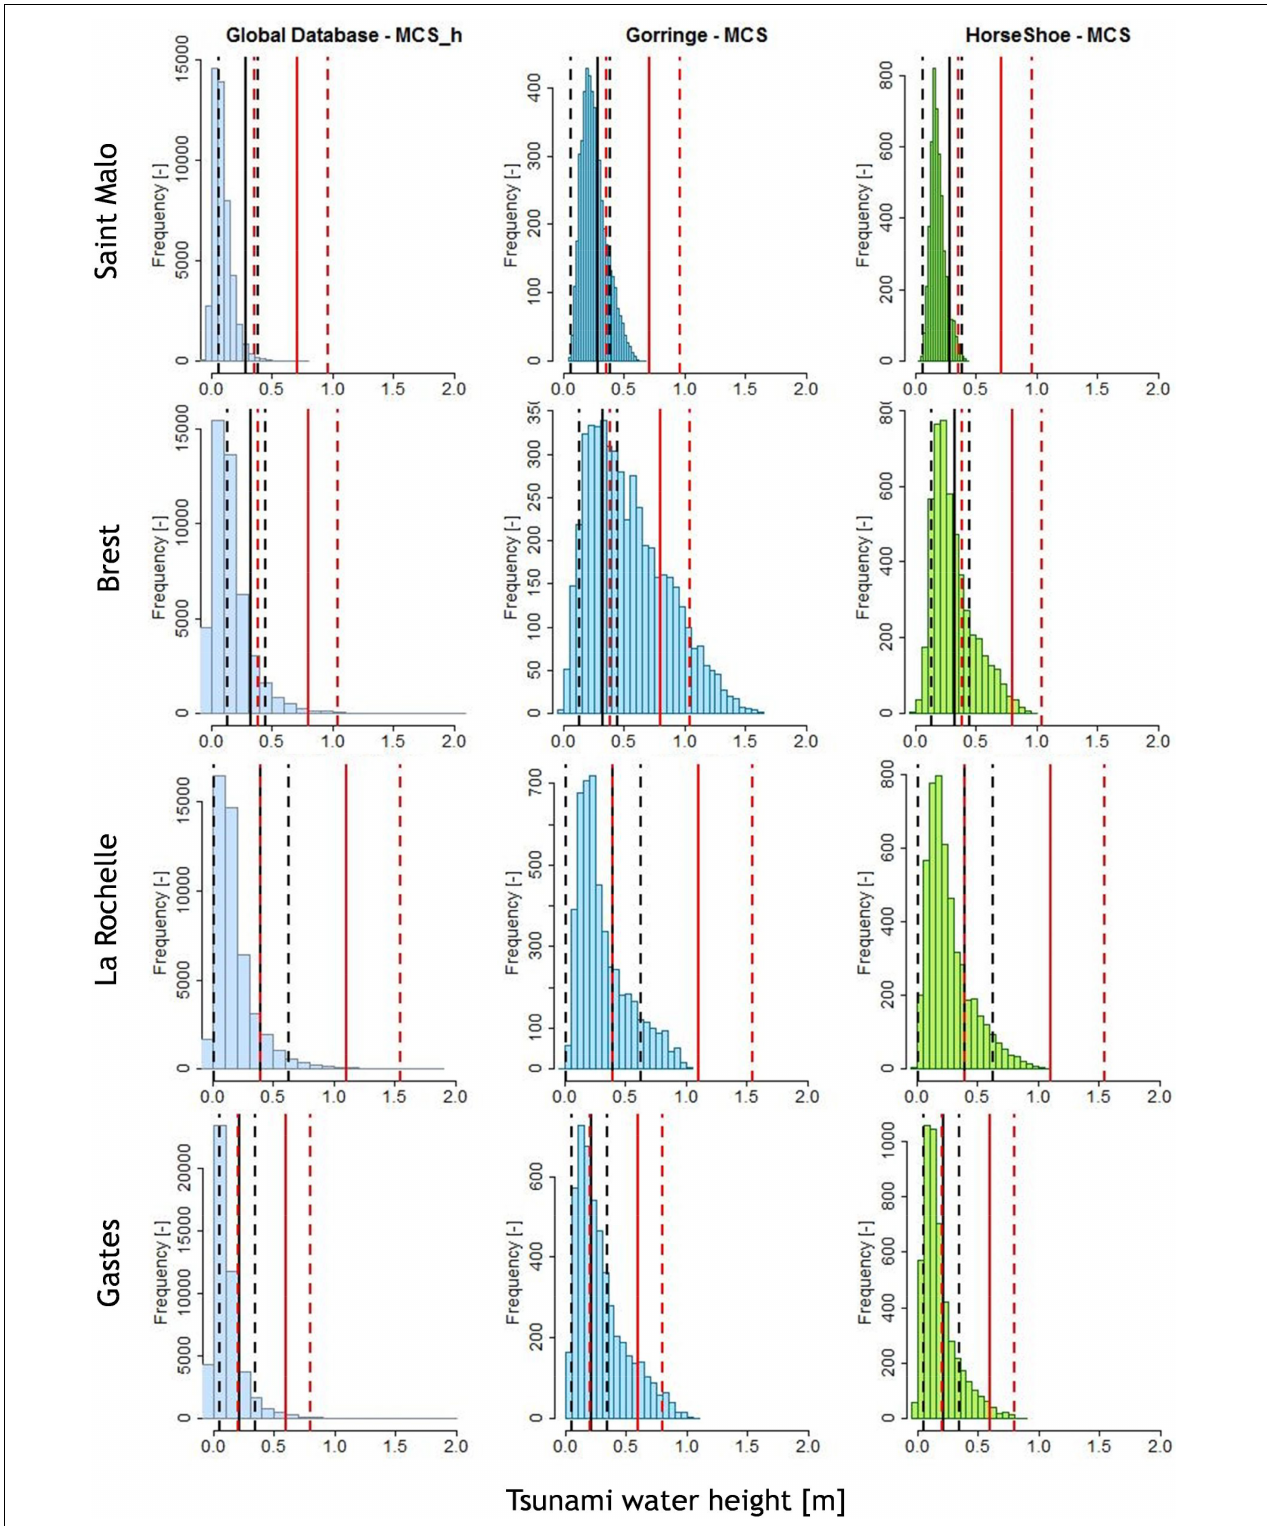
FIGURE 6 | Tsunami height frequency distribution associated to the global data base (gray-blue), the Gorringe bank (blue) and the Horseshoe bank (green). The black and red lines correspond, respectively, to the mean tsunami height associated to a return period of 1 000 and 10 000 years issued by TSUMAPS-NEAM research project. Dotted lines represent the 2th and 98th percentile of the hazard